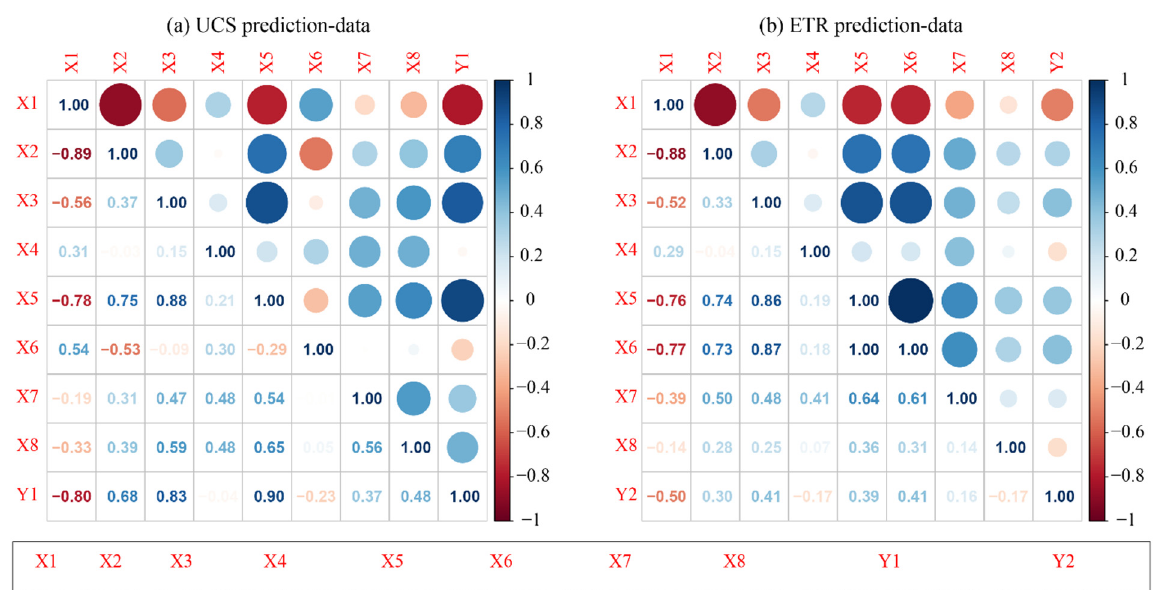
Figure 2. The demonstration of parameter correlation analysis: ( a ) UCS prediction and ( b ) ETR pre- diction.